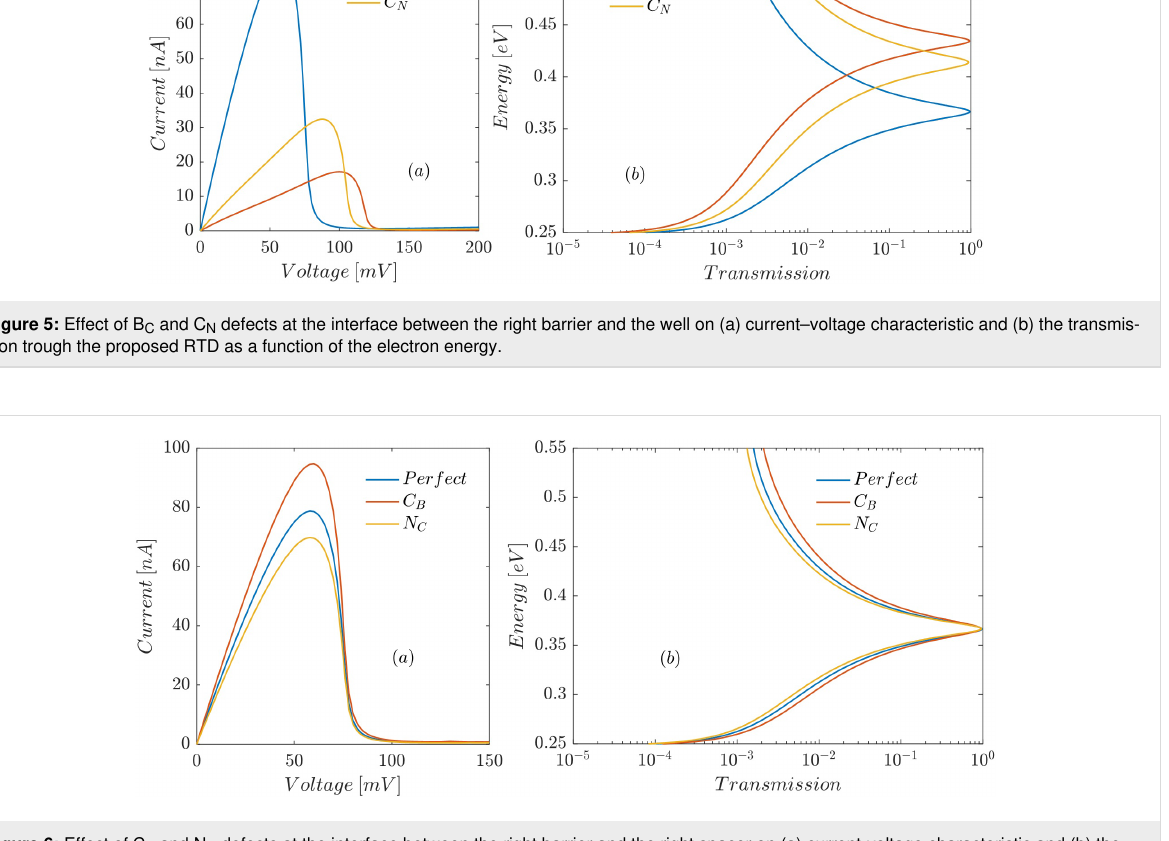
Figure 6: Effect of C B and N C defects at the interface between the right barrier and the right spacer on (a) current-voltage characteristic and (b) the transmission trough the proposed RTD as a function of the electron